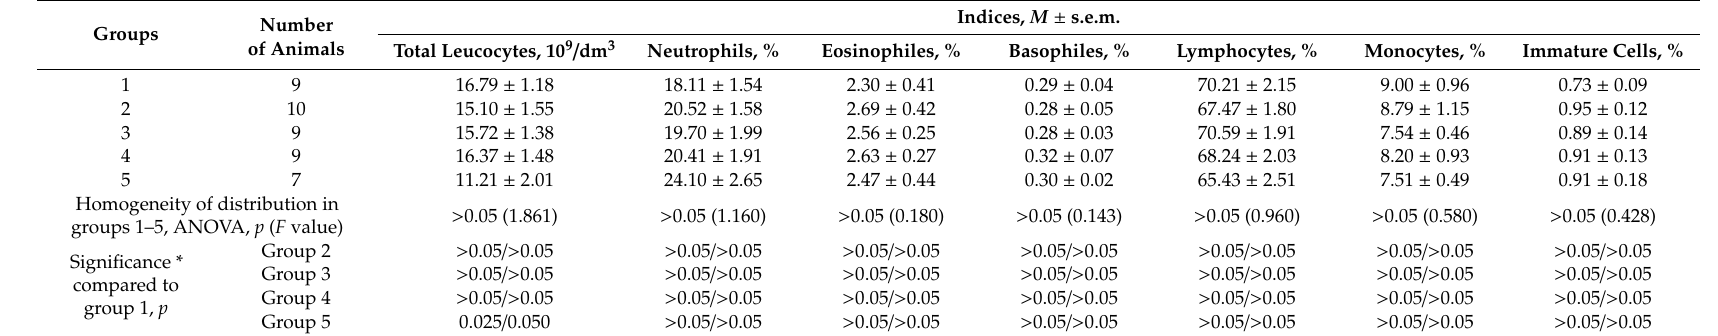
Table 3. Leucocyte counts in groups 1–5 on the 93rd day of the